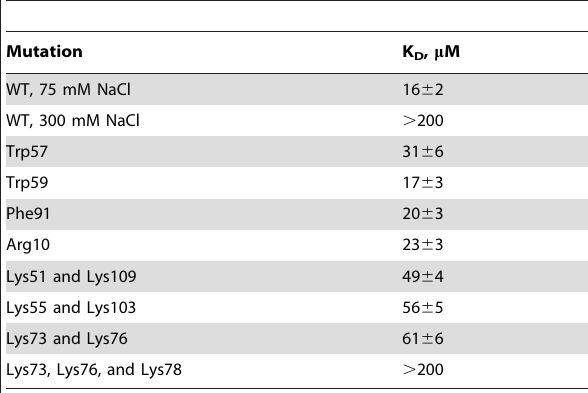
Table 1. Effects of ionic strength and amino acid substitutions on the dissociation constant for AggAdsA- fibronectin